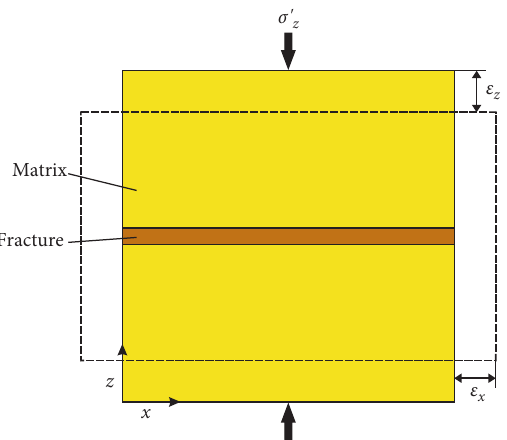
Figure 30: A fractured rock under normal